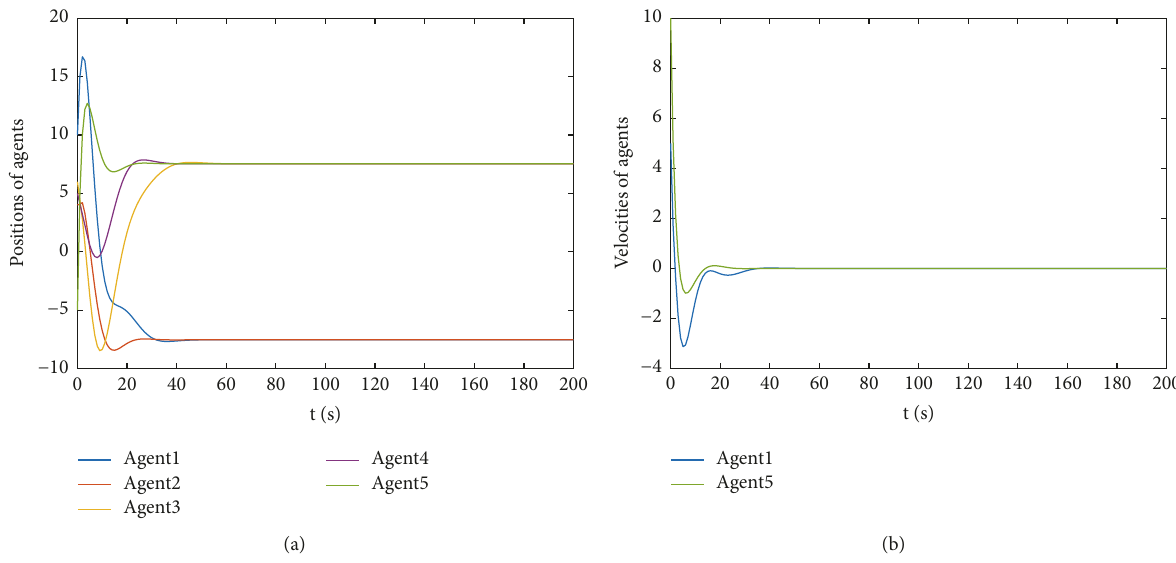
Figure 3: The state trajectories of the agents under directed topology in Figure 1 with different input time delays 𝜏 1 = 0.5 , 𝜏 2 = 4.5 , 𝜏 3 = 4.5 , 𝜏 = 4.5, 𝜏 = 0.5 , and 𝜏 = 1 . (a) Positions, (b) Velocities. 4 5 𝑖𝑗